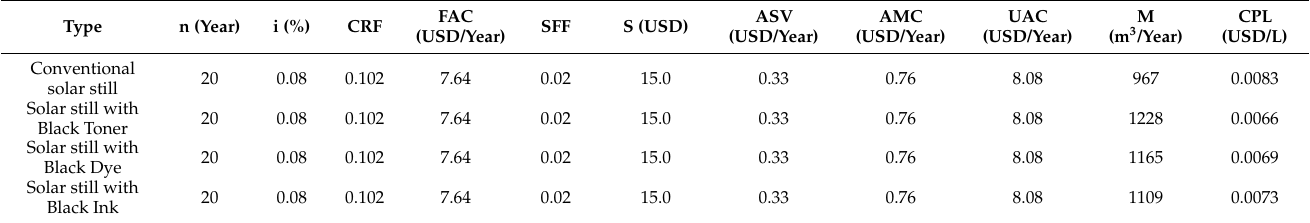
Table 5. Economic analysis of solar desalination using different absorber material.